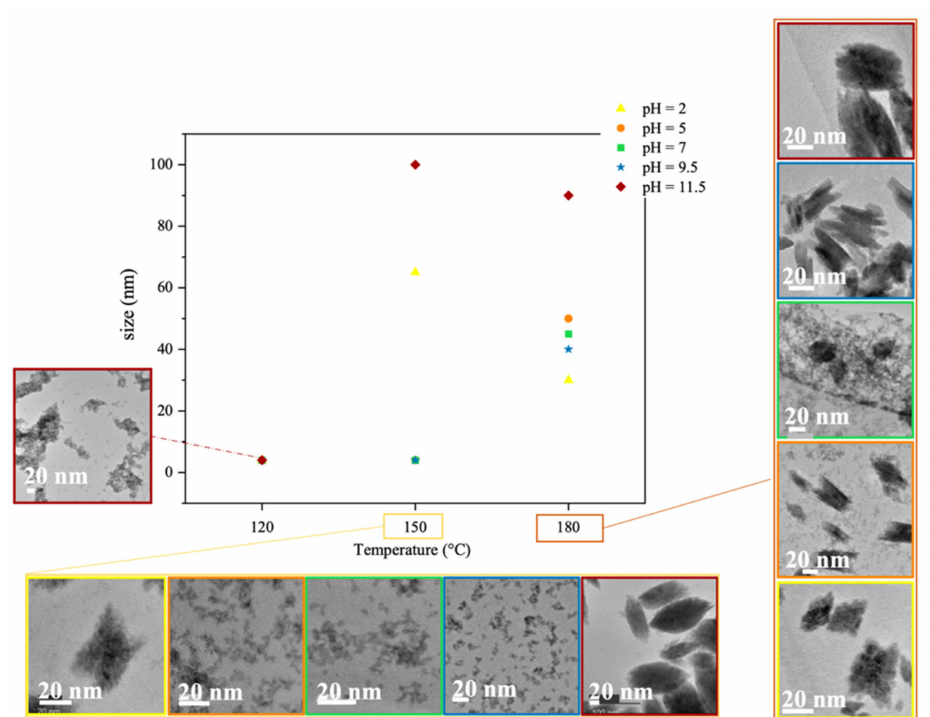
Figure 6. HfO 2_NPs size after 6 h of hydrothermal growth at different temperatures and pHs, with corresponding transmission electron bright field micrographs. At 150 ◦ C, three points (orange, blue and green) are superimposed.